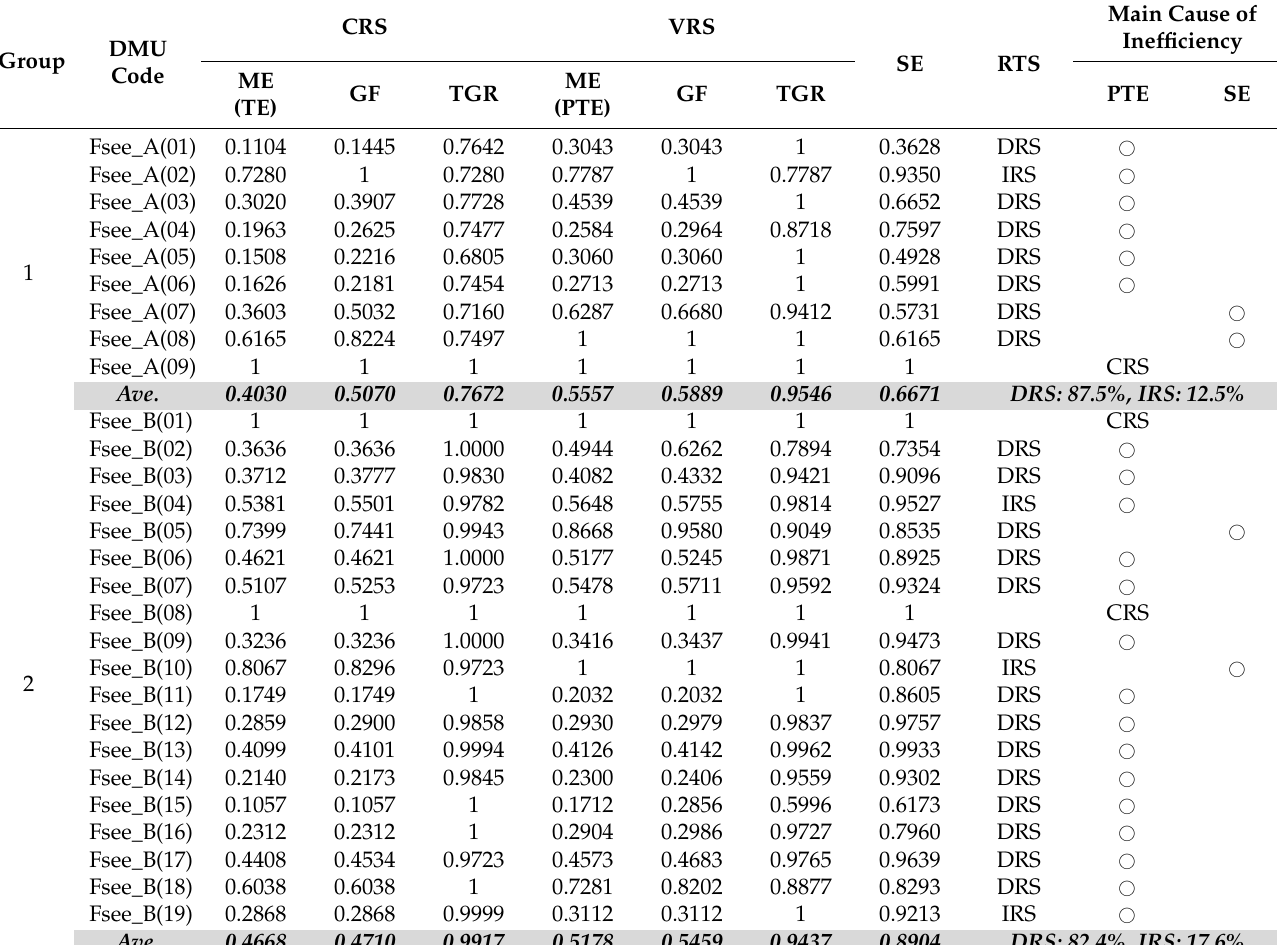
Table 4. Meta-efficiency of